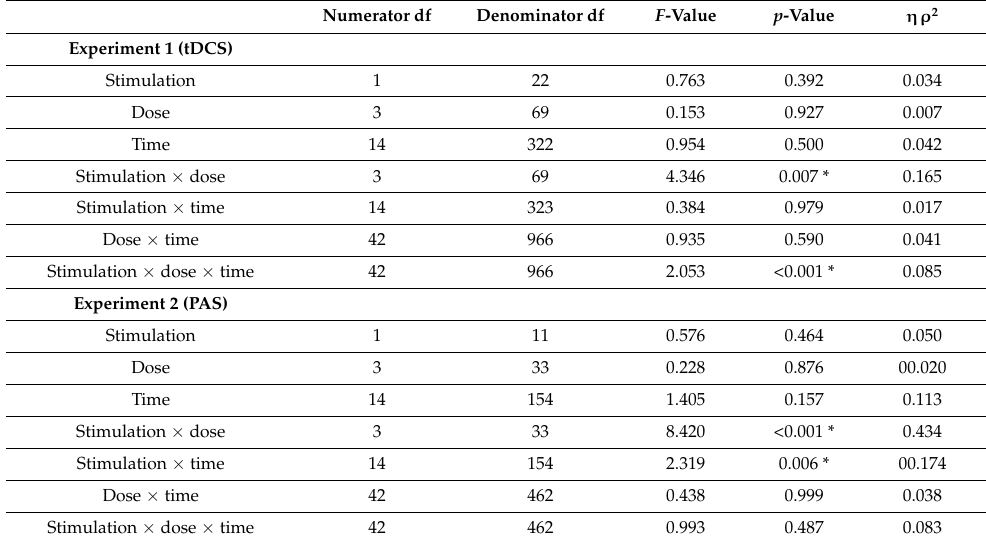
Table 2. Results of the ANOVAs performed for Experiment 1 and